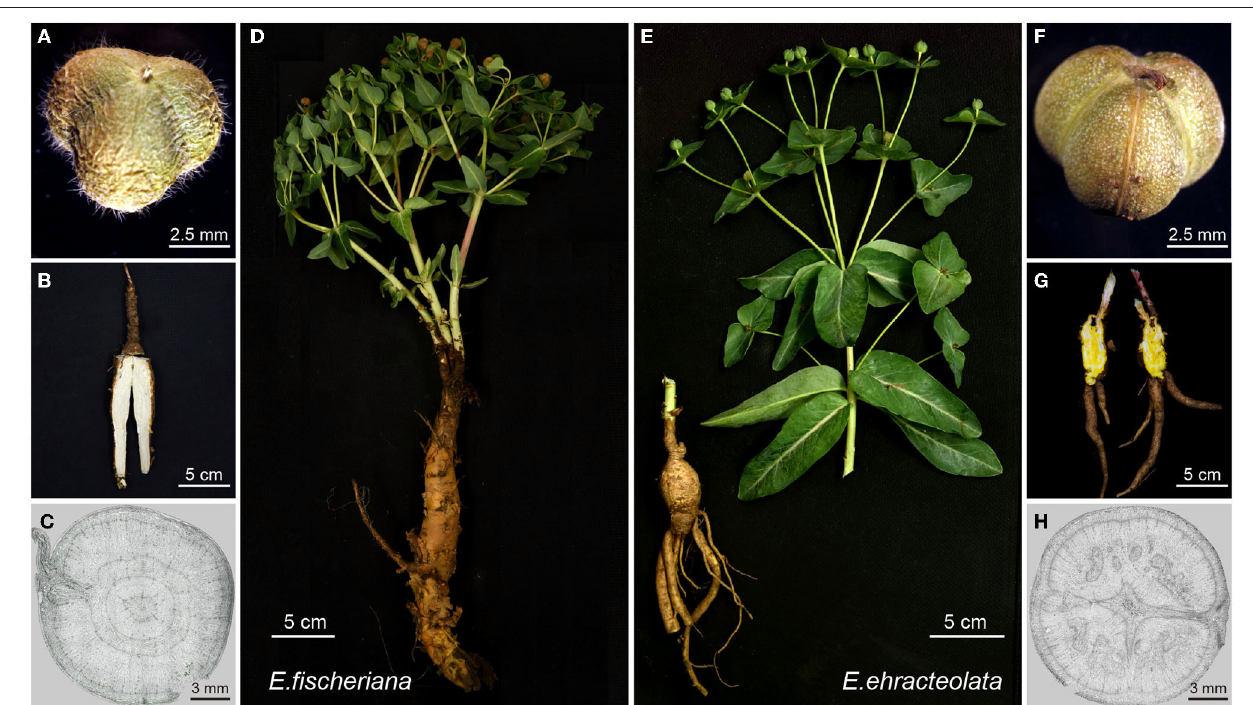
FIGURE 1 | Two species of Langdu characteristic diagrams. (A) Fruit of E. fischeriana ; (B) longitudinal section of E. fischeriana root; (C) cross-section micrograph of E. fischeriana root; (D) whole E. fischeriana plant; (E) whole E. ehracteolata plant; (F) fruit of E. ehracteolata ; (G) longitudinal section of E. ehracteolata root; (H) cross-section micrograph of E. ehracteolata